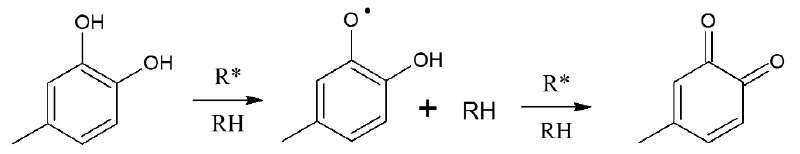
Figure 6. Flavonoids—free radical scavenging